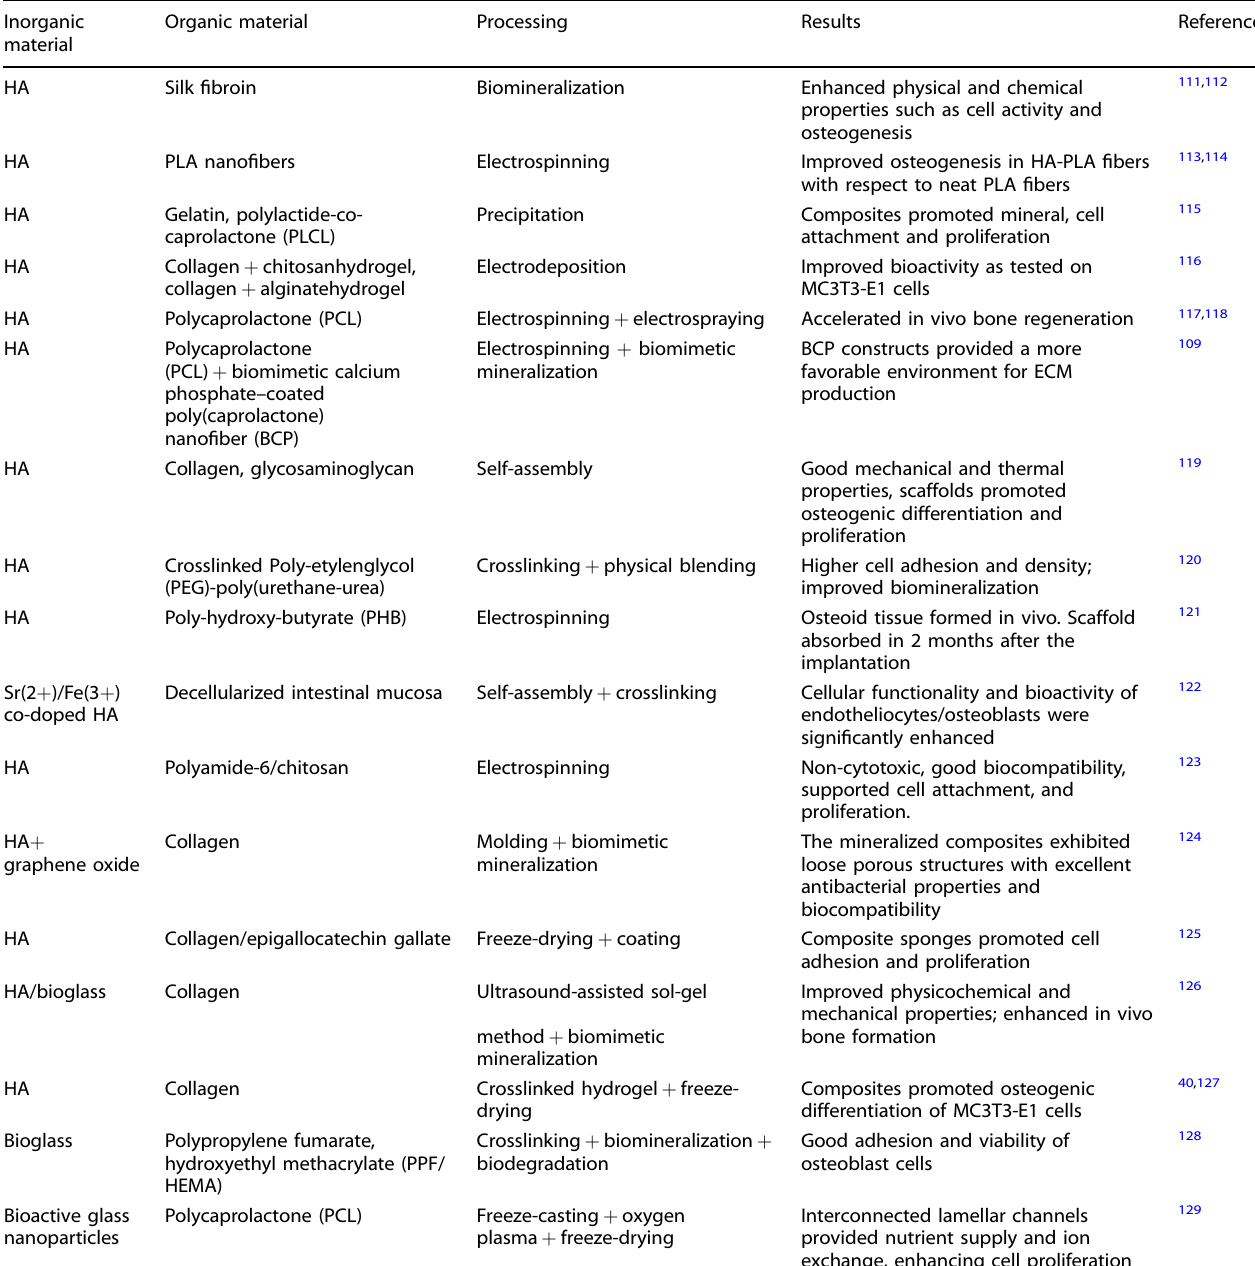
Table 2. Composites for bone